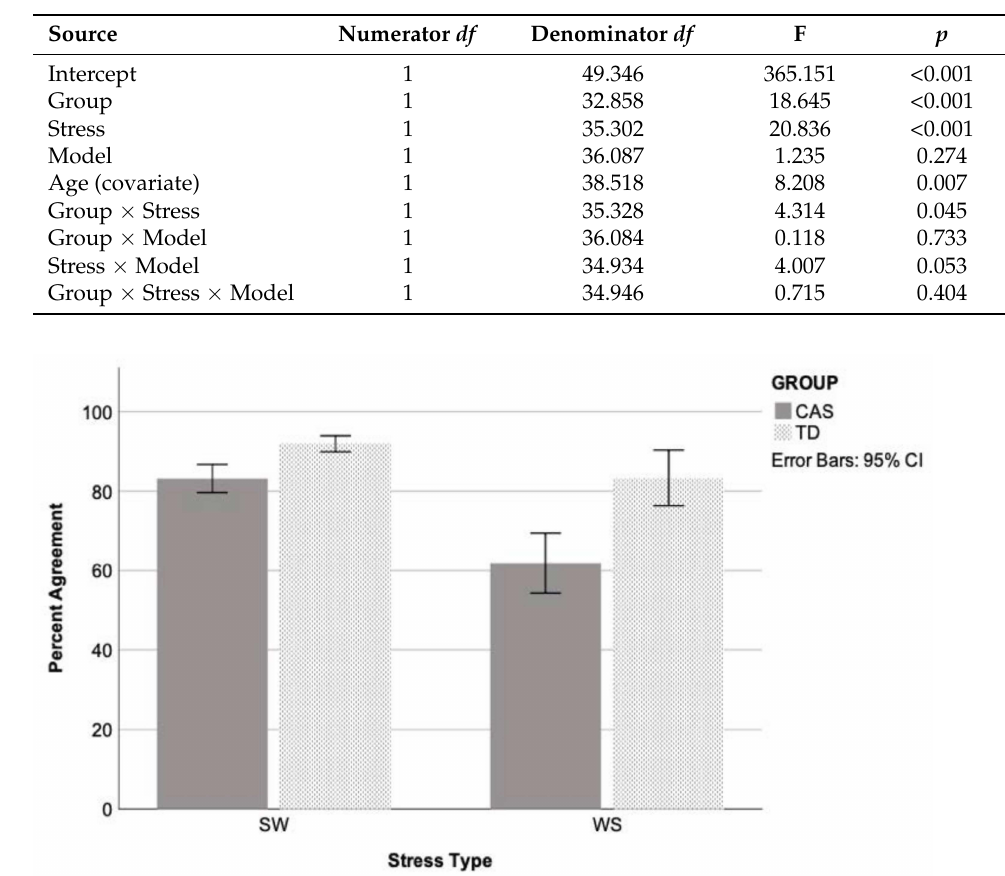
Figure 3. Percent agreement between human and tool for the typically developing (TD) and childhood apraxia of speech (CAS) groups across words with strong–weak (SW) and weak–strong (WS) lexical stress, pooled across single-pronunciation and multiple-pronunciation HMM model types. Error bars represent 95% confidence intervals.